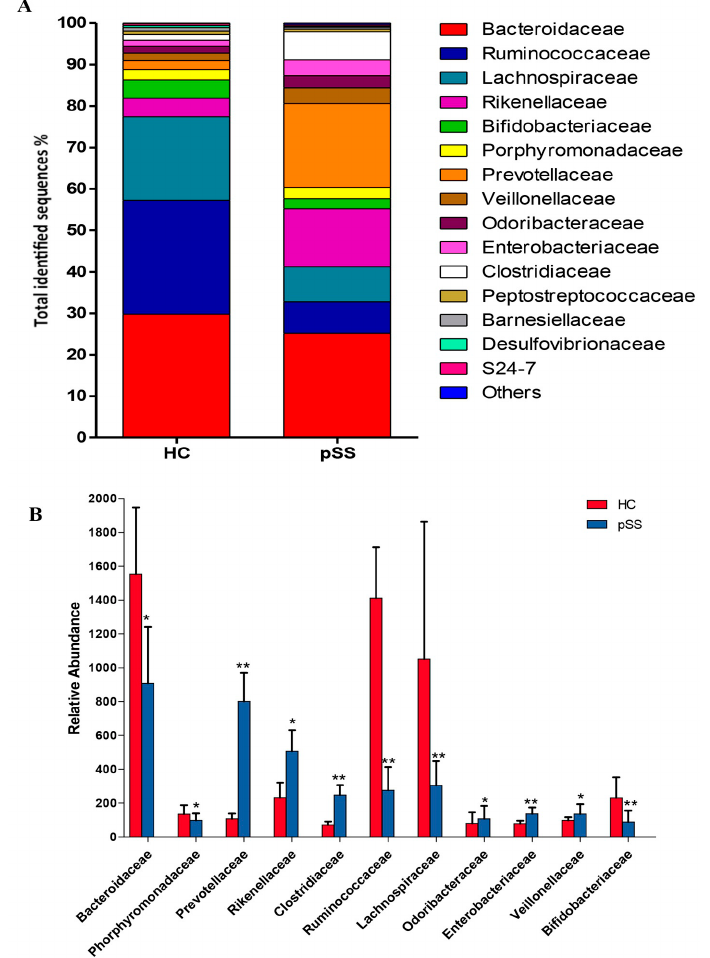
Figure 4. Family-level microbial classification of bacteria from stool samples of primary Sjögren’s syndrome (pSS) patients and healthy controls (HC). ( A ) Data are shown as a percentage of the total identified sequences per group. ( B ) Differentially abundant families in the stool samples of pSS patients compared to HC. * p < 0.05, ** p < 0.001. The bars indicate mean ± standard deviation (SD).